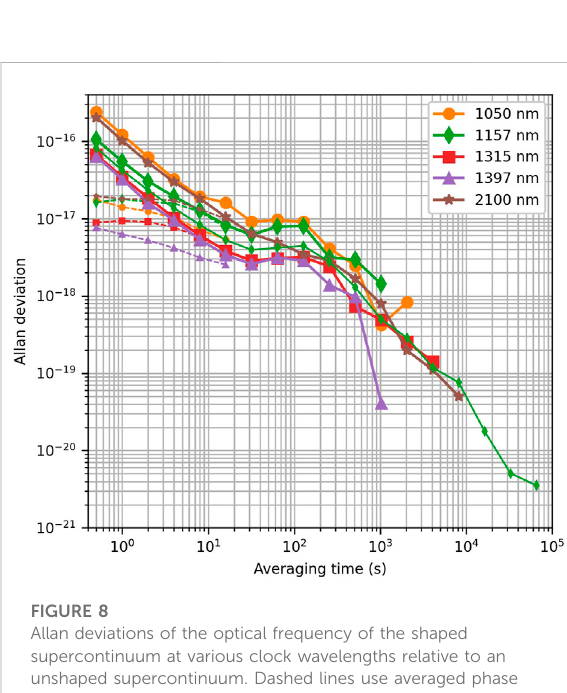
Allan deviations of the optical frequency of the shaped supercontinuum at various clock wavelengths relative to an unshaped supercontinuum. Dashed lines use averaged phase values over 0.5 s to remove white noise. Deviations at 1 s are at the 10 − 17 level, which is already comparable to the best optical